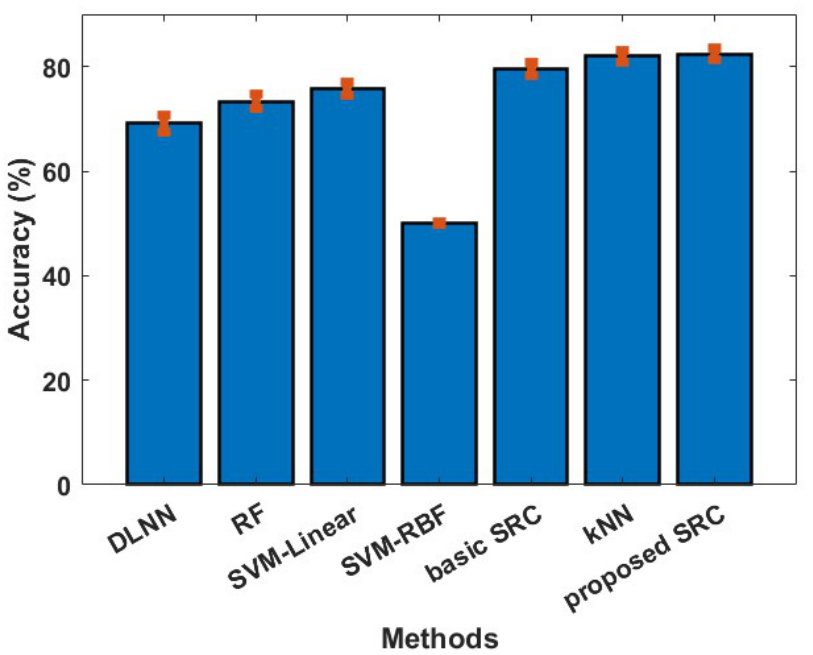
Figure 1. Averaged classification accuracy (with standard error) between the least and most preferred